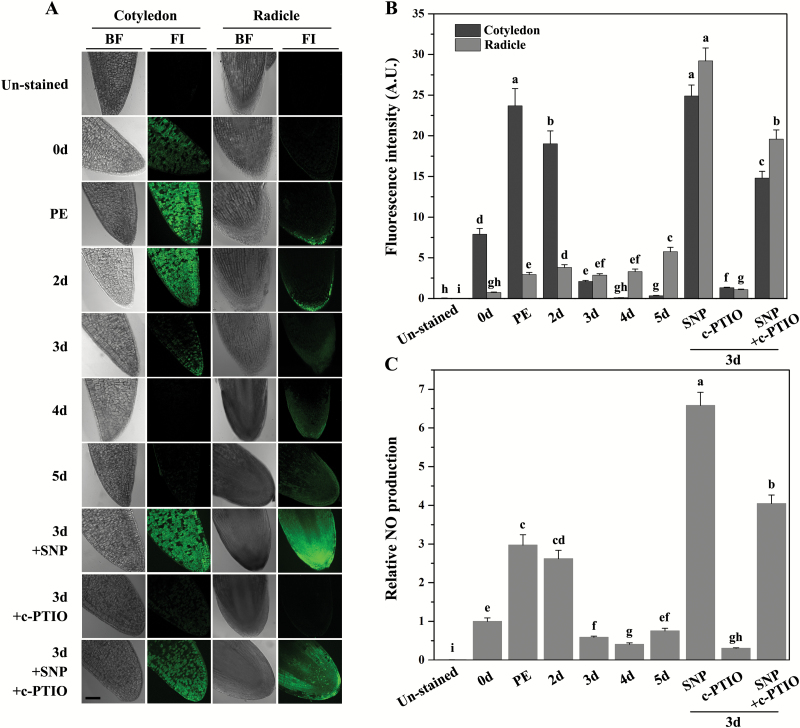
NO production during seed deterioration. The seeds were subjected to CDT for 0 d, post-equilibration (PE), 2, 3, 4, and 5 d, or pre-treated with 100 μM SNP, 50 μM c-PTIO, or SNP plus c-PTIO before 3 d of CDT. (A) Representative fluorescent images of NO production in ageing seeds. Seed sections were incubated with DAF-FM DA and detected using confocal laser scanning microscopy. The cotyledon and radicle were observed separately. Bright field (BF) and fluorescence images (FI) are listed in different columns. Scale bars=0.1 mm. (B) Relative DAF-FM DA fluorescence signal densities of (A). Data are the mean ±SD of six replicates. Different superscript letters indicate a significant difference of the fluorescence signal at P<0.05. (C) Spectrofluorometric analysis of NO levels in whole seeds during ageing. Data are the mean ±SD of six replicates. Different superscript letters indicate a significant difference in the fluorescence signal at P<0.05.